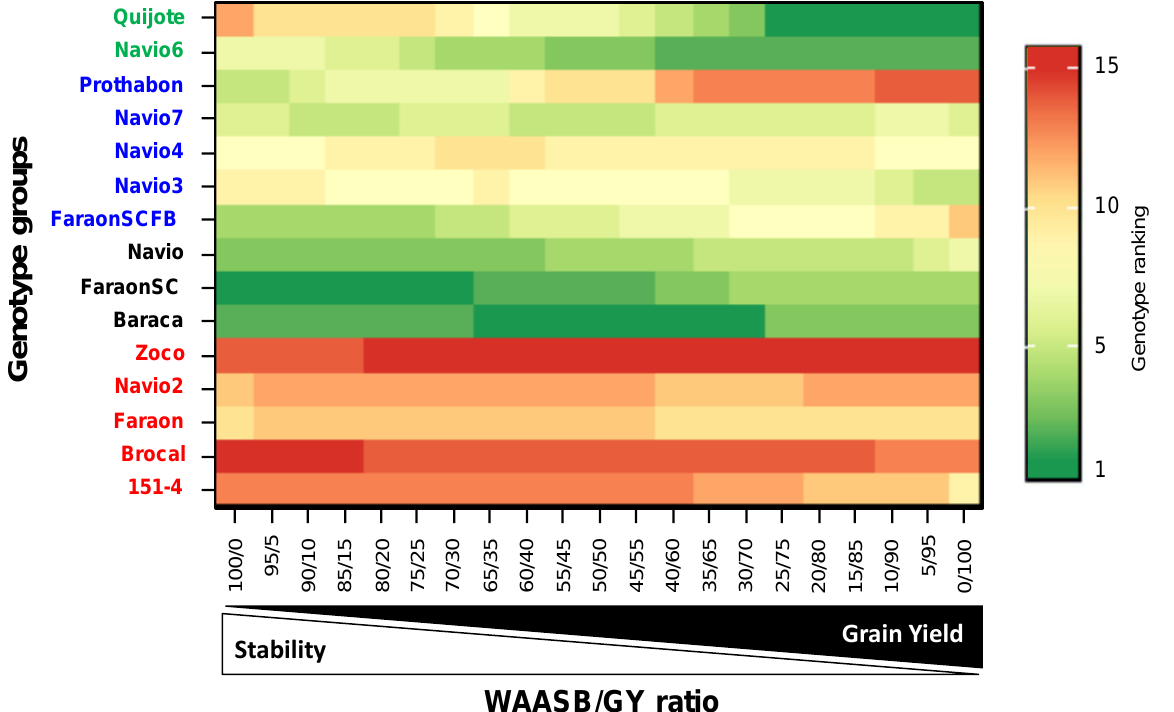
Figure 2. Heatmap showing the rank of 15 faba bean accessions assigning different weights for stability and yield, from 100/0 (stability only) to 0/100 (grain yield only). Four clusters of accessions are shown on the left side of heat map (names in different color) according to stability and productivity.